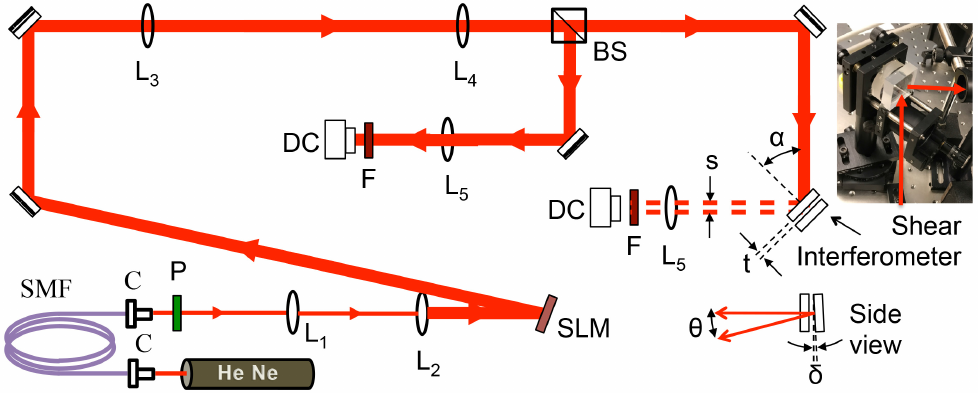
Figure 6. Apparatus used to make the measurements. Components include the spatial light modulator (SLM) lenses (L i ), fiber collimators (C), single-mode fiber (SMF), beam splitter (BS), polarizer (P), neutral density filters (F) and digital camera (DC). The insert shows a photo of the shear